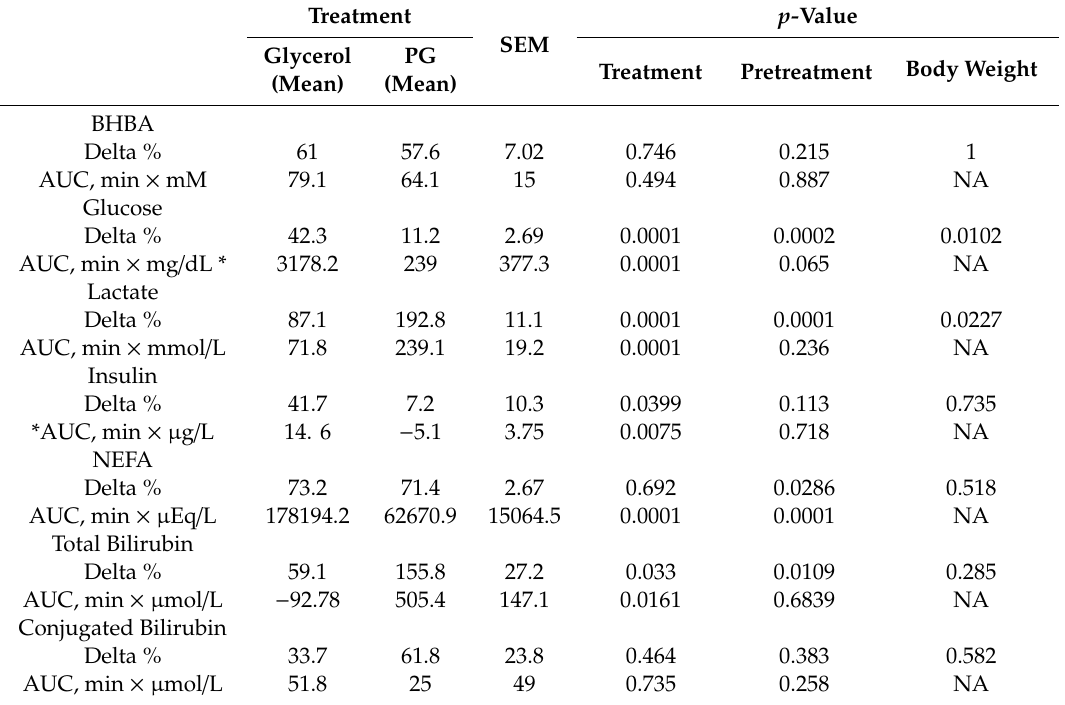
Table 2. E ff ect of intravenous infusion of glycerol and propylene glycol (PG) on the percentage delta (Delta %) and area under the curve (AUC) for concentrations of nutrients, metabolites, and hormones in the blood.